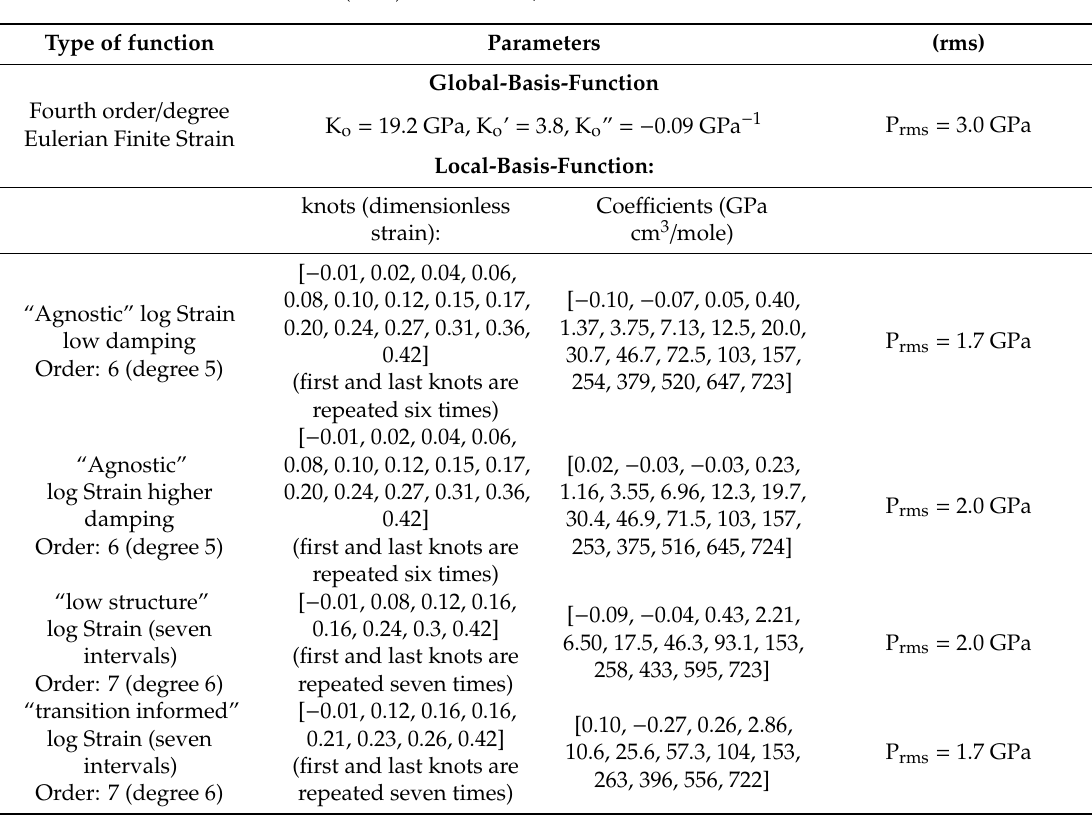
Table 3. Equation of state parameters and root-mean-square (rms) pressure misfits (P rms ) for representations of high-pressure ice VII and X 300 K isotherm. Units for all parameters are shown. V o for ice VII is taken from Klotz (2017): 12.7218 cm 3 / mol or 42.25 Å 3 at 300